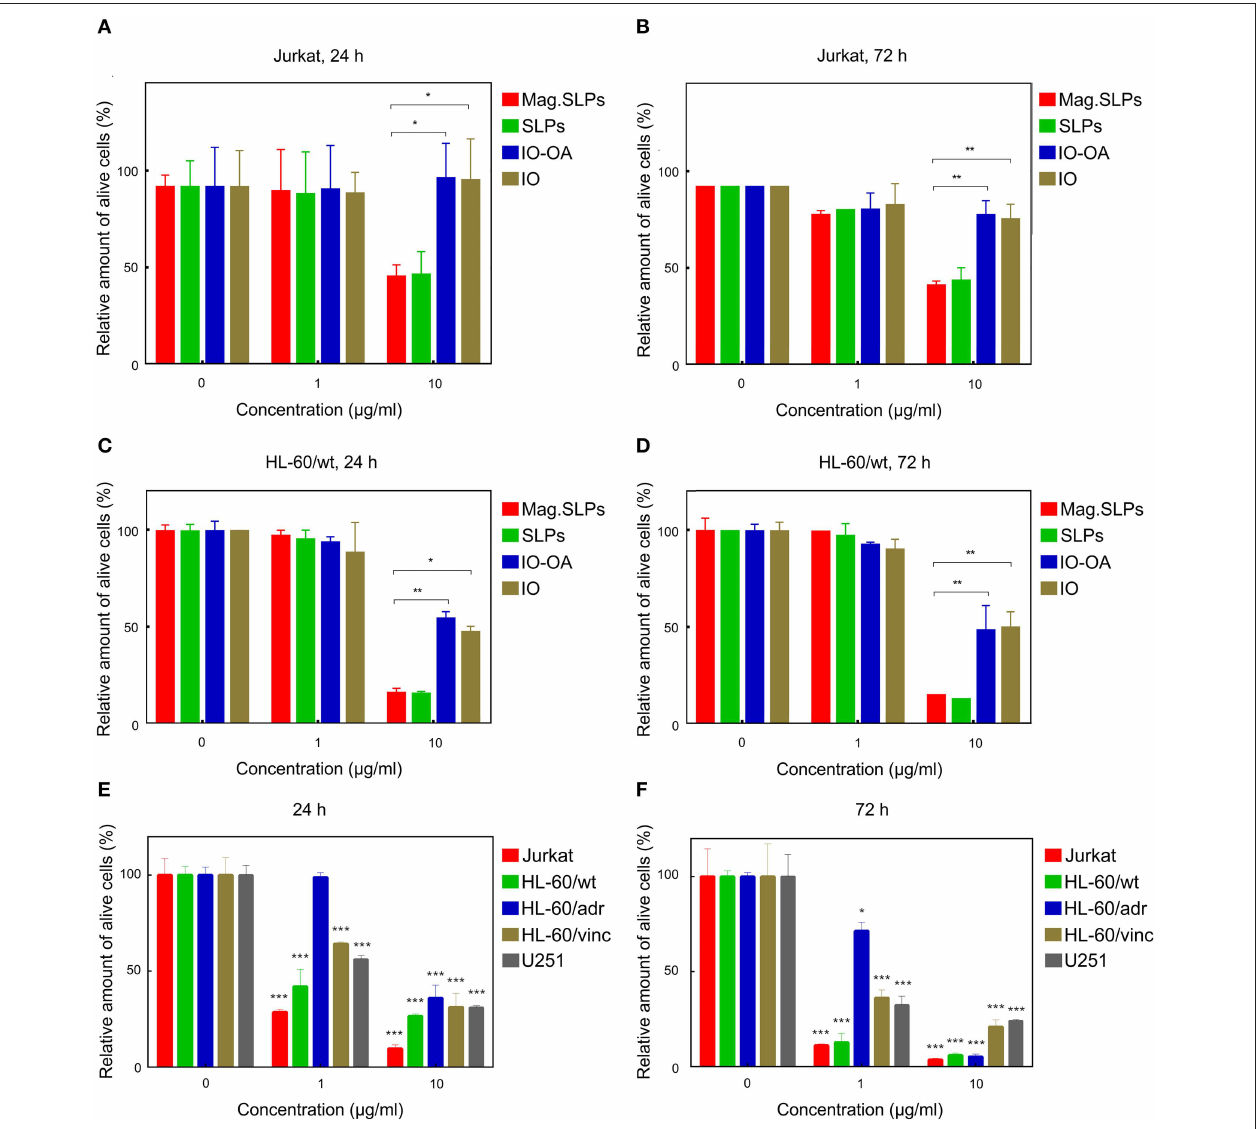
FIGURE 5 | Cytotoxicity of mag.SLPs, SLPs, IO-OA, and IO particles against (A,B) T leukemia Jurkat cells and (C,D) human myeloid leukemia HL-60/wt cells determined by MTT assay after (A,C) 24 and (B,D) 72h of incubation. (E,F) Cytotoxicity of Dox toward T leukemia Jurkat cells, human myeloid leukemia HL-60/wt cells, human myeloid leukemia HL-60/adr cells resistant to Dox, human myeloid leukemia HL-60/vinc cells resistant to vincristine, and human glioblastoma U251 cells determined by trypan blue exclusion test after (E) 24 and (F) 72h of incubation. * p ≤ 0.05, ** p ≤ 0.01, and *** p ≤ 0.001 compared to non-treated control